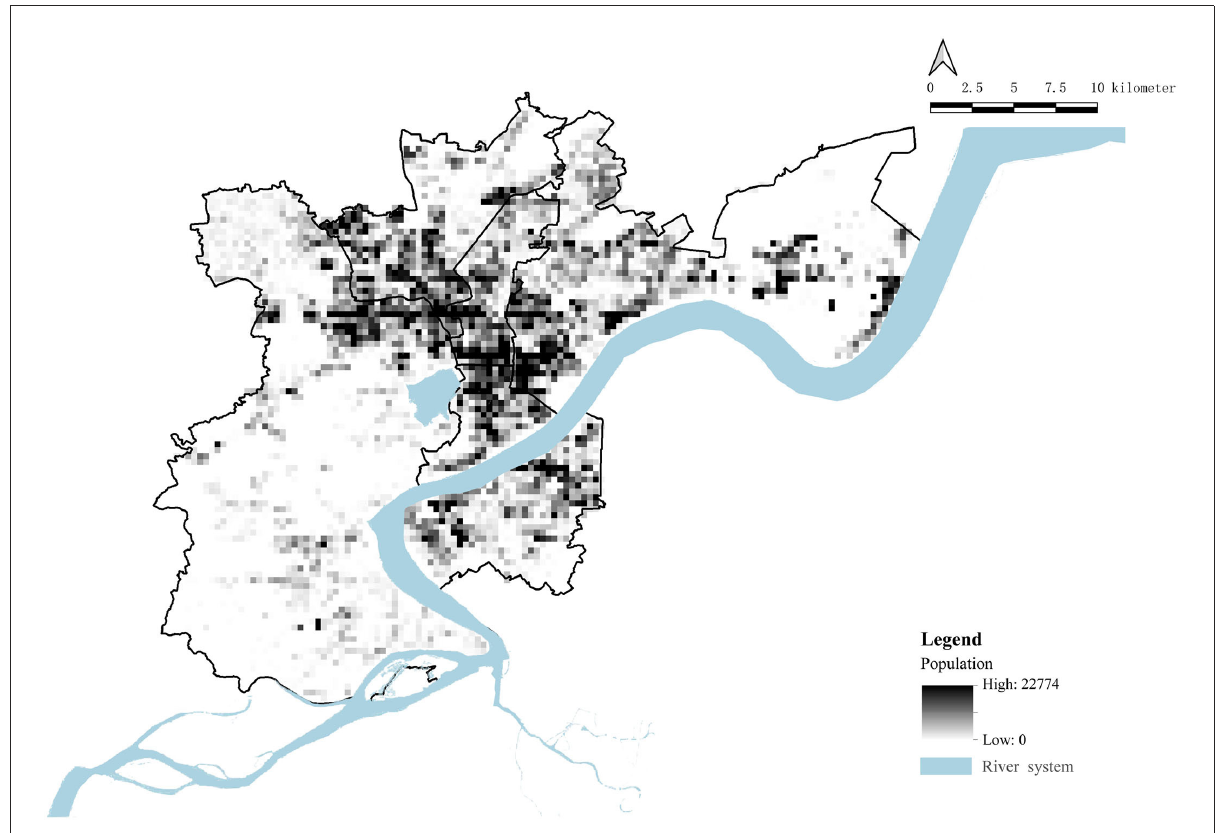
FIGURE2 Population data of the six